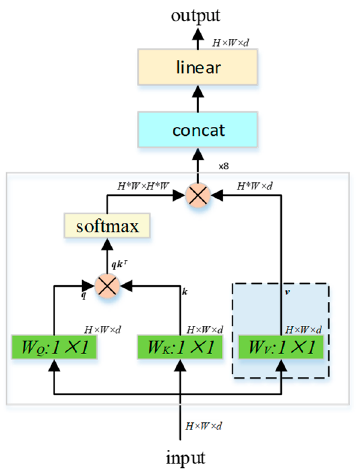
Figure 3. Multi-head attention.